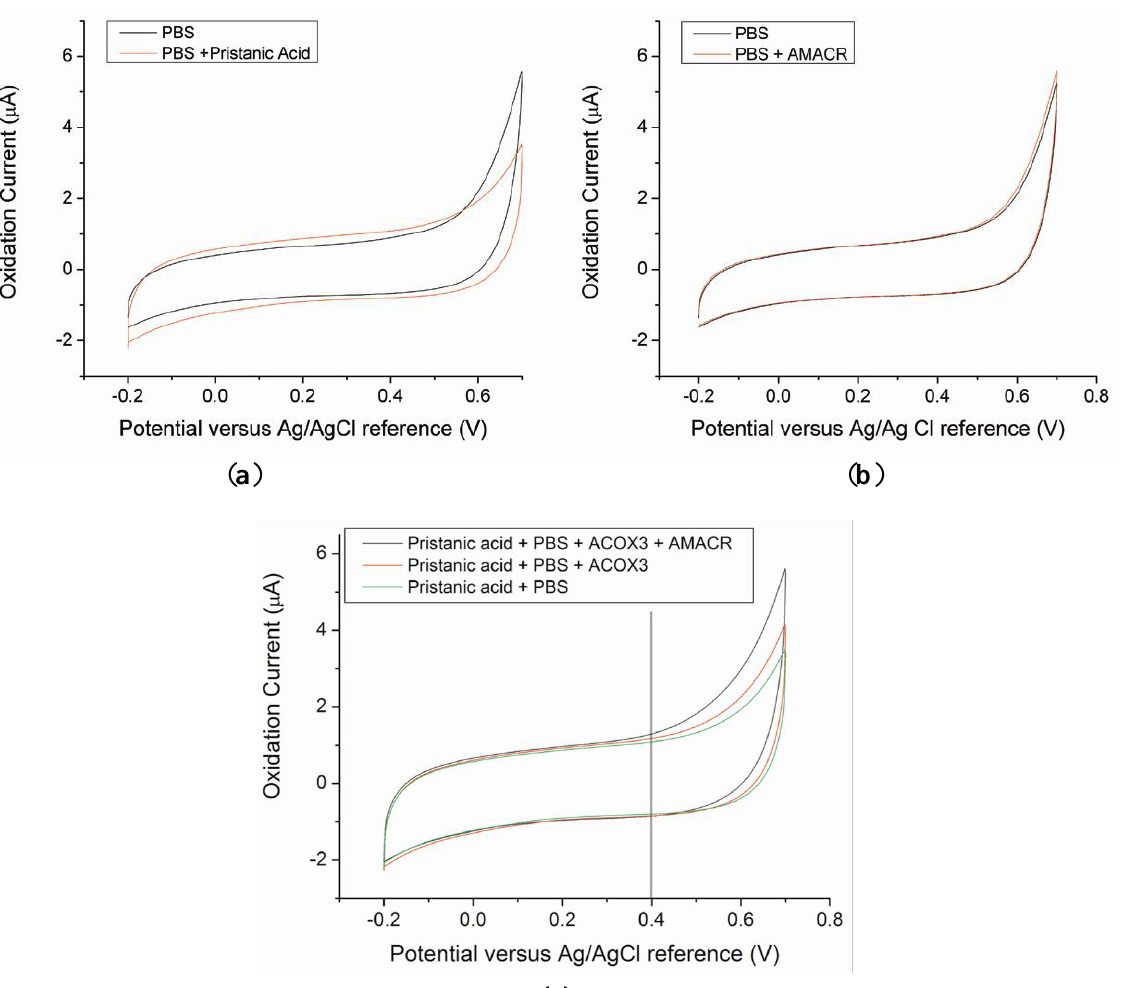
Figure 3. Cyclic Voltammograms of control sample solutions of PBS media, PBS + pristanic acid ( a ), and PBS + AMACR (0.0065 µg/µL) ( b ), The CVs obtained show that